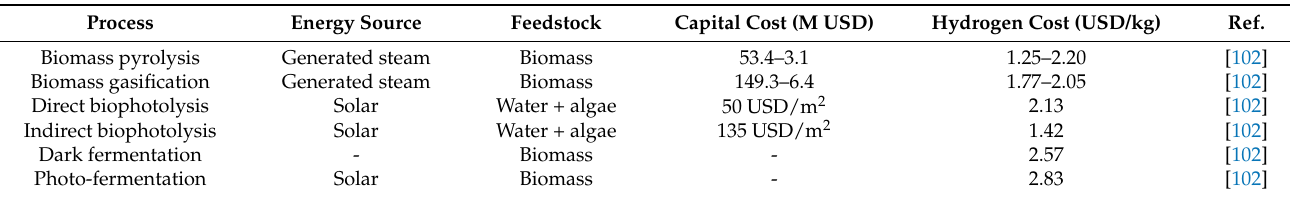
Table 5. Hydrogen production costs by different